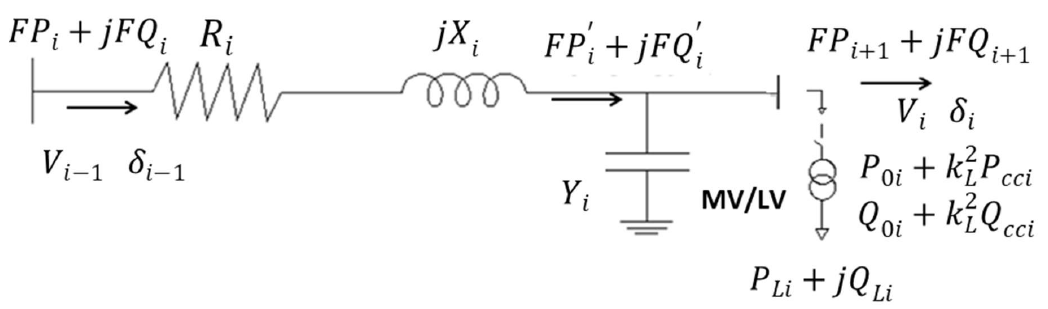
Figure 2. Block diagram for the power flow calculation.